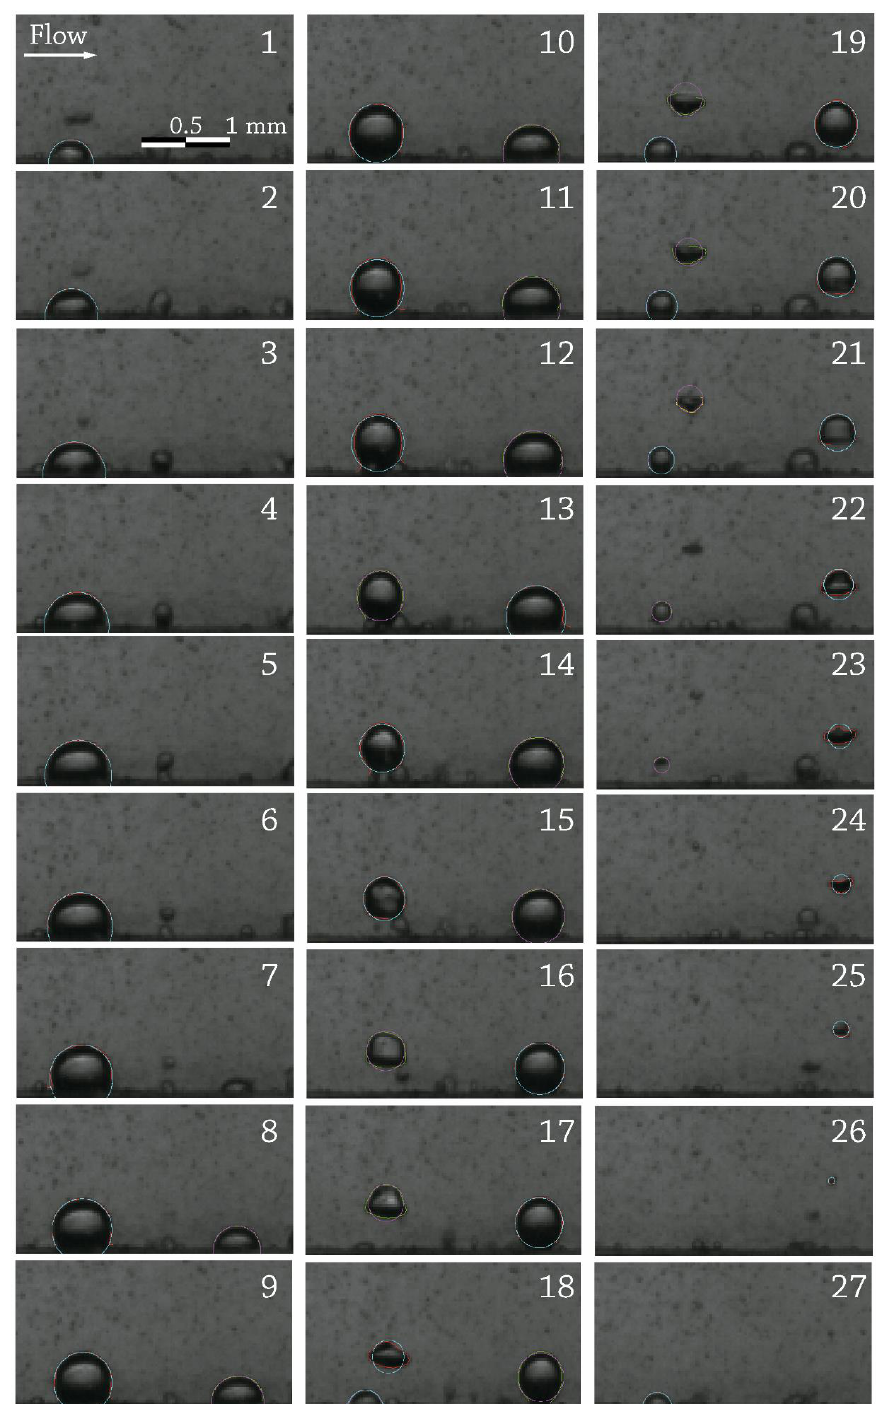
Figure 10. Side projection post-processing result example, T b = 95 °C, p = 150 kPa, G = 241 kg/m 2 /s, v = 0.25 m/s, q w = 300 kW/m 2 . Graphical output for recognized bubble contours (time interval between frames: 0.25 ms).